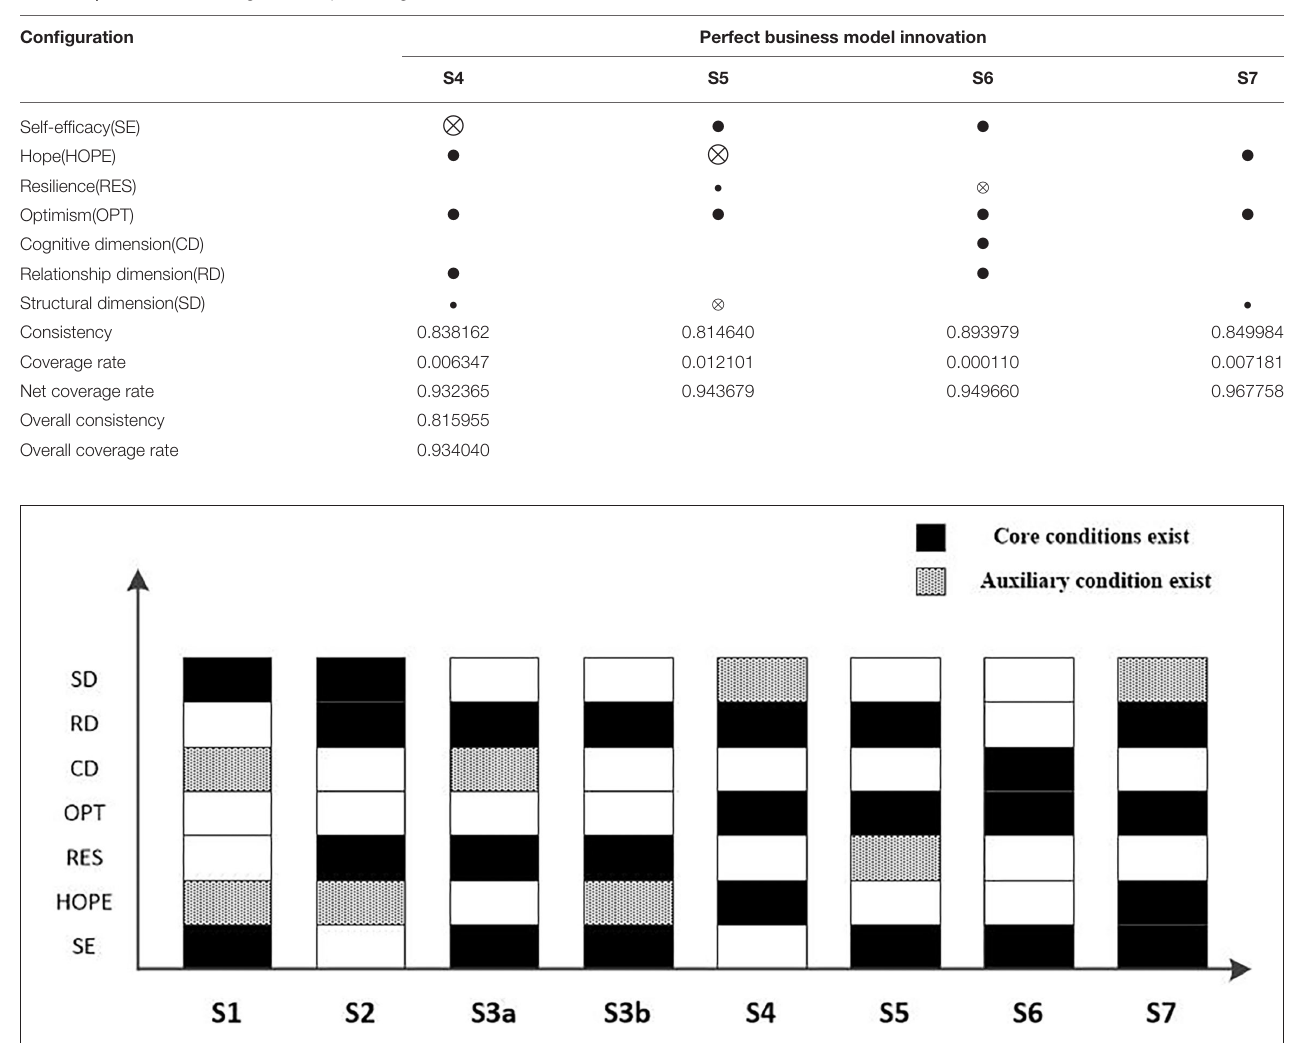
TABLE 7 | Pre-condition configuration of pioneering business model innovation.